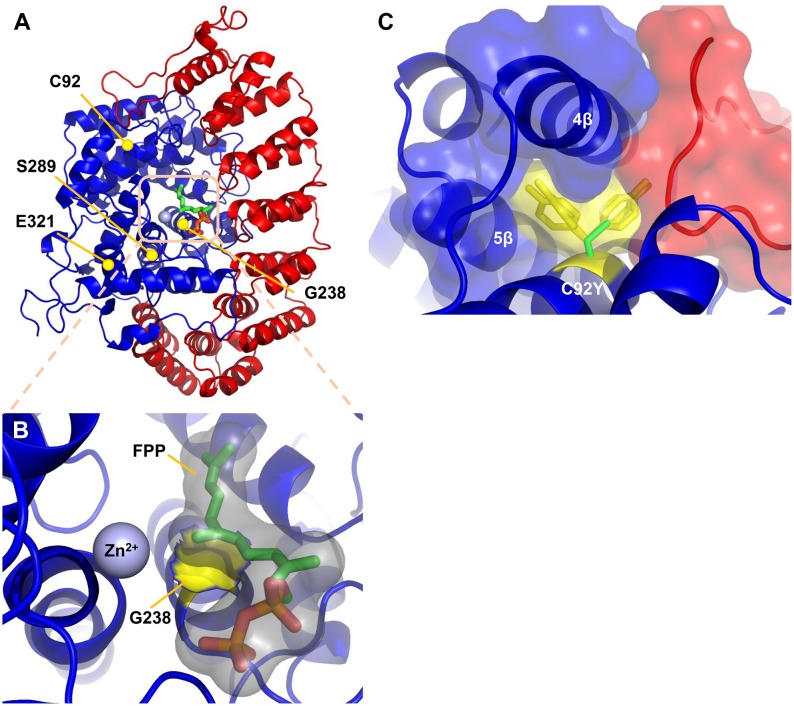
FNTB-1 missense mutations mapped to human FTase.(A) Crystal structure of the human protein FTase (PDB ID: 1S63) heterodimer (α subunit; red and β subunit; blue). Yellow circles mark the location of residues C104, G250, S301 and Q336 of the worm FTase. Lipid substrate farnesyl diphosphate, (FPP: isoprenoid moiety, green; diphosphate, red) and zinc ion (grey sphere) mark the site of catalysis. (B) Enlarged view of the FTase active site. G250 (yellow surface representation) makes van der Waals contact with FPP (grey surface). Any mutation at position 250 would result in a larger side chain that would affect FPP binding. (C) Enlarged view around residue C92 in worm FTase (C104 human FTase; green stick). The four major rotamers for the C104Y mutation and their corresponding van der Waals surfaces are shown in yellow. A van der Waals surface calculated around the alpha subunit (red) and beta subunit (blue) is shown. Any tyrosine rotamer results in a steric class with the protein. This mutation is predicted to compromise the packing and the stability of the enzyme.